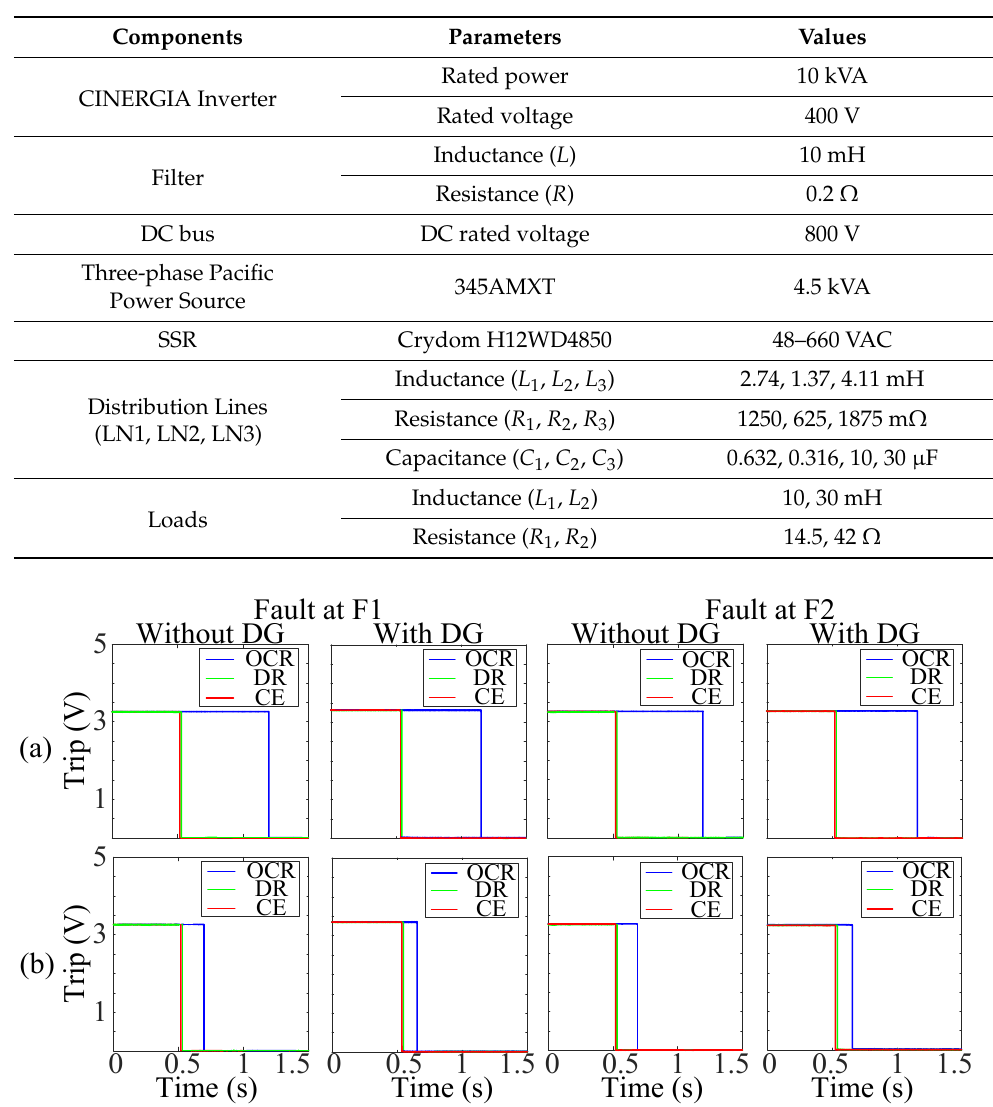
Figure 11. Simulation and experimental abc voltages and currents of PD5, PD6, and trip signals of the CE-ZO algorithm decision in the case of a three-phase fault, and a single-phase at F2.